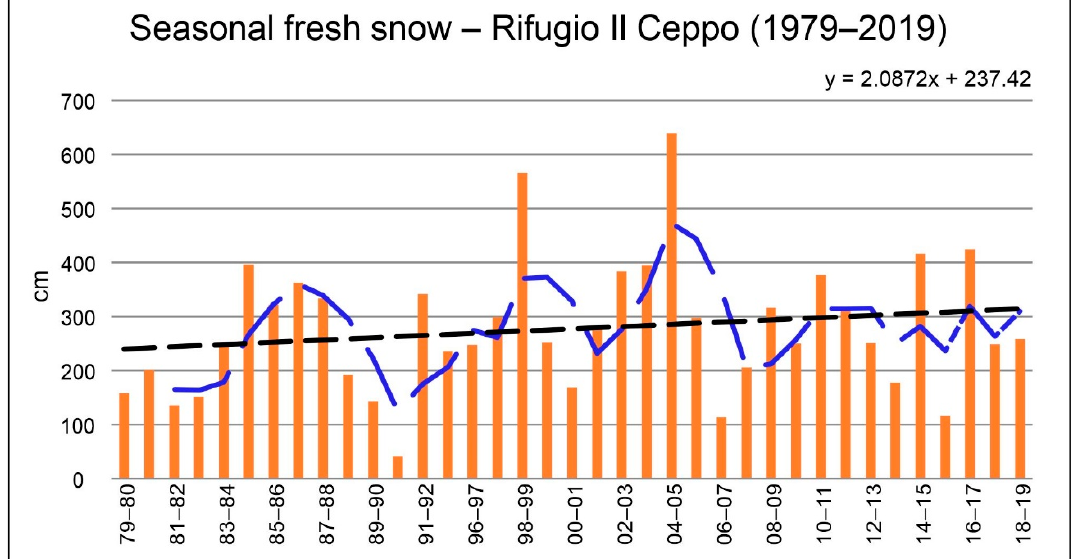
Figure 11. Seasonal fresh snow at Rifugio Il Ceppo (1340 m a.s.l.). The blue dashed line represents the 5-year moving average.